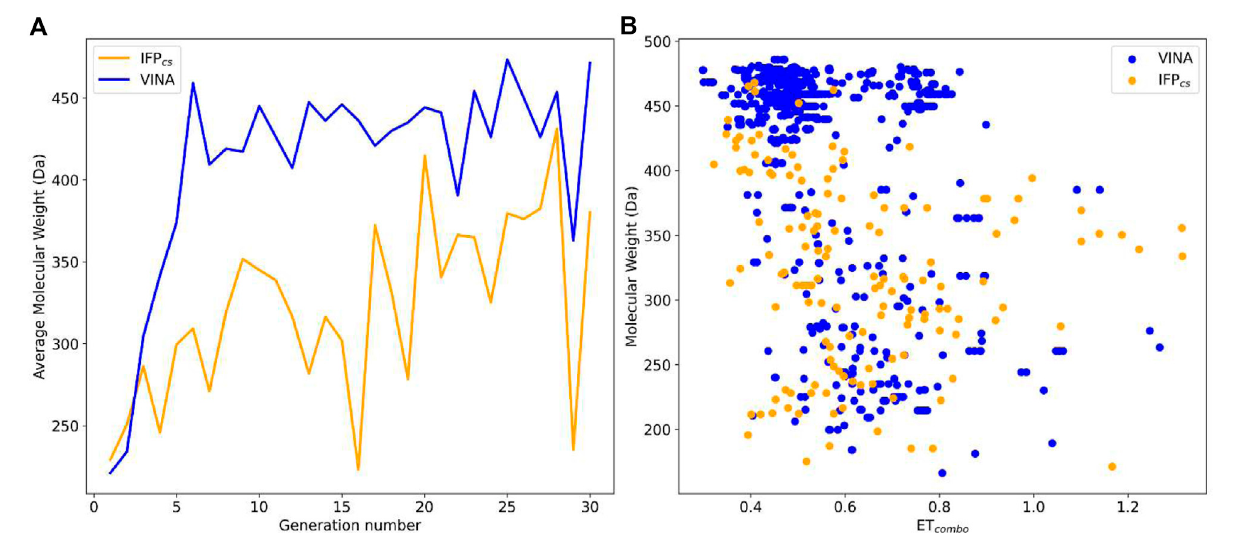
FIGURE4| ComparisonoftheperformanceofthetwoAutogrowprotocolsinthebenchmark denovo runsregardingtheirabilitytogeneratecompoundsthatpass thepharmacophore fi lter.TheVINA protocolisreportedasablue line,while theIFP CS oneisreportedasanorangeline.Panel (A) depicts, foreachprotocol, theaverage molecularweight ofcompounds within thepopulation thatpassthe pharmacophore fi lteron aper-generation basis.The vertical axis reports the molecular weight,while thehorizontalaxisreportsthegenerationnumber.Panel (B) depicts,foreachprotocol,thedistributionofgeneratedcompoundsthatpassthepharmacophore fi lter regarding their molecular weight and the similarity of shape and electrostatic properties to crystal inhibitors taken as reference. The vertical axis reports the average molecularweightinDa,whilethehorizontalaxisreportsthe ET